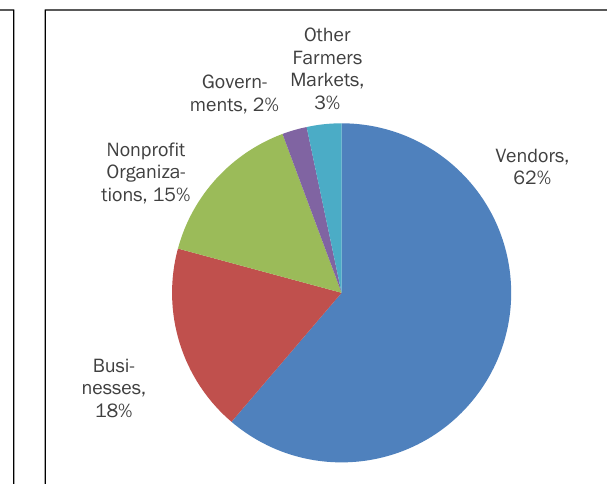
Figure 4. Composition of the Social Network for Cedar Park Farmers Market’s Facebook Page (a) Distribution of Posts by Post Owner (b) Distribution of Organization Fans ( N